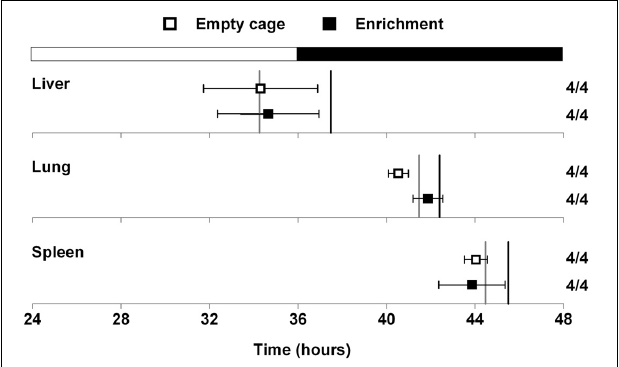
FIGURE 3 | Effect of environmental enrichment on tissue rhythms. Male heterozygous PER2::LUC mice were single-housed in either empty cages (open squares) or in cages with enrichment (1 cardboard hut and 2 pieces of shredding paper; filled squares). Mice were fed high-fat diet for 1 week. The mean ( ± SD ) phases were determined from the peaks of PER2::LUC expression during the interval between 12 and 36h in culture and were plotted relative to the time of last lights on where 24h is lights on and 36h is lights off (black and white bar at top). The sample size is shown (number of rhythmic tissues/number of tissues tested). The phases of the PER2::LUC rhythms in liver, lung, and spleen were not altered by environmental enrichment. For reference the gray vertical lines show the phases of the tissues from mice housed with locked wheels and the black vertical lines show the phases of the tissues from mice with freely rotating wheels (data shown in Figure 2